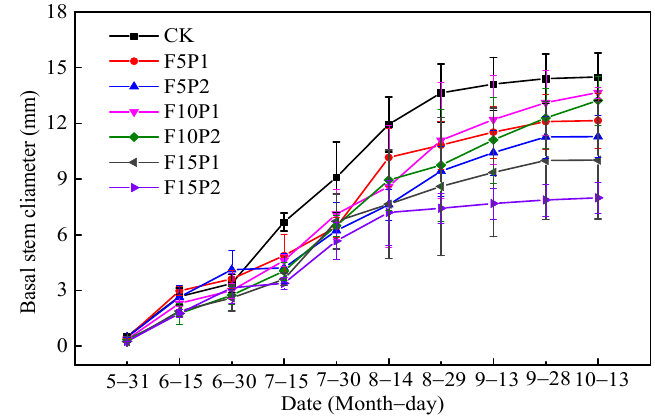
Figure 4. Effects of CSL on basal stem diameter of Artemisia ordosica .